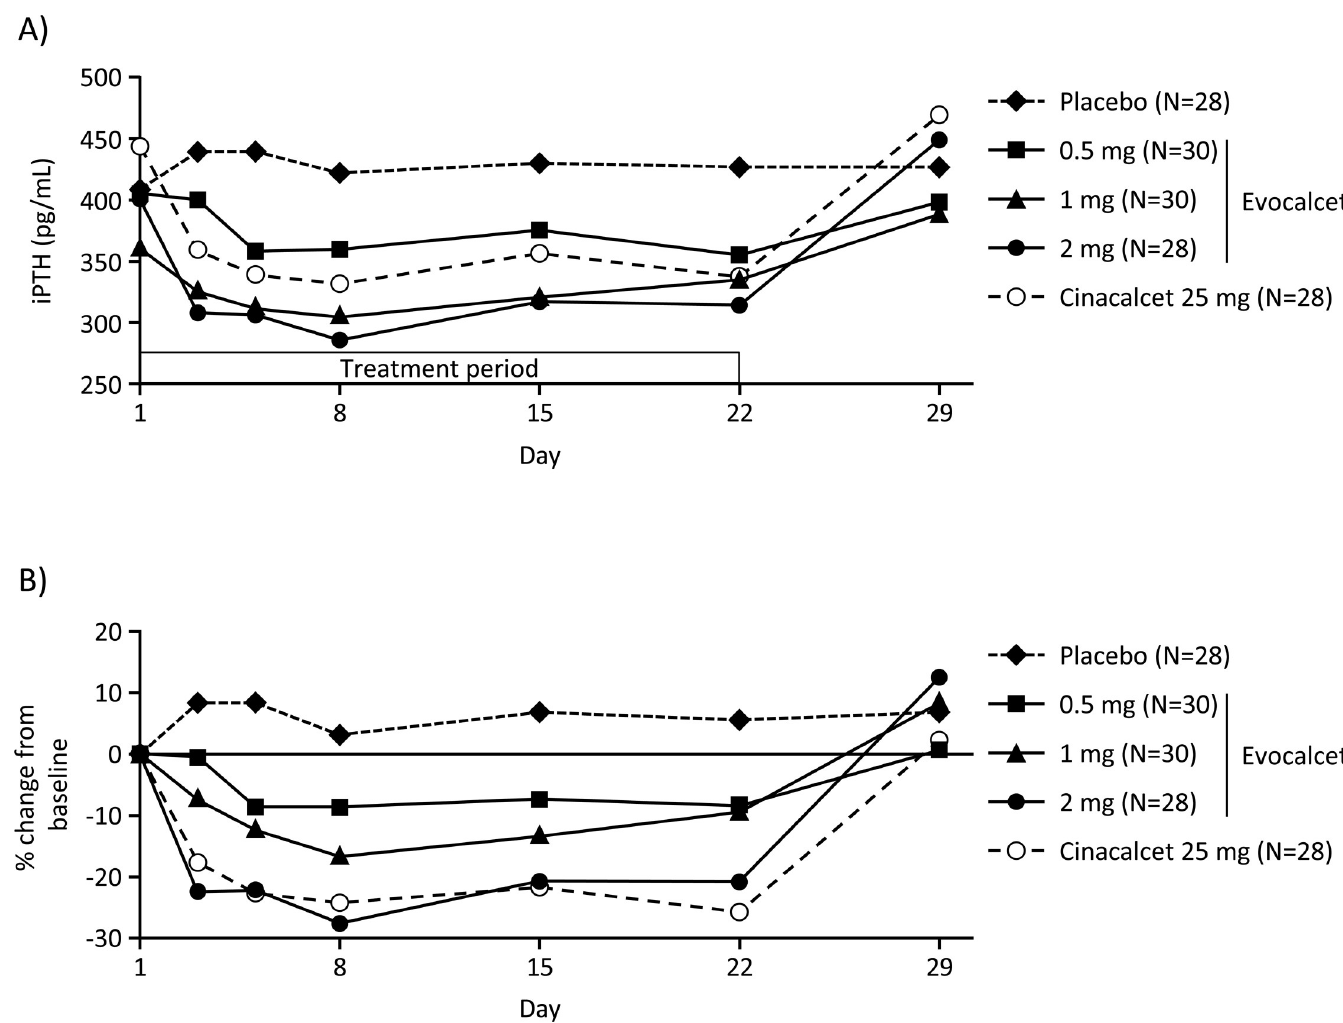
Fig 5. Time-course profile of iPTH (A) and percent change from baseline (B). iPTH, intact parathyroid hormone.